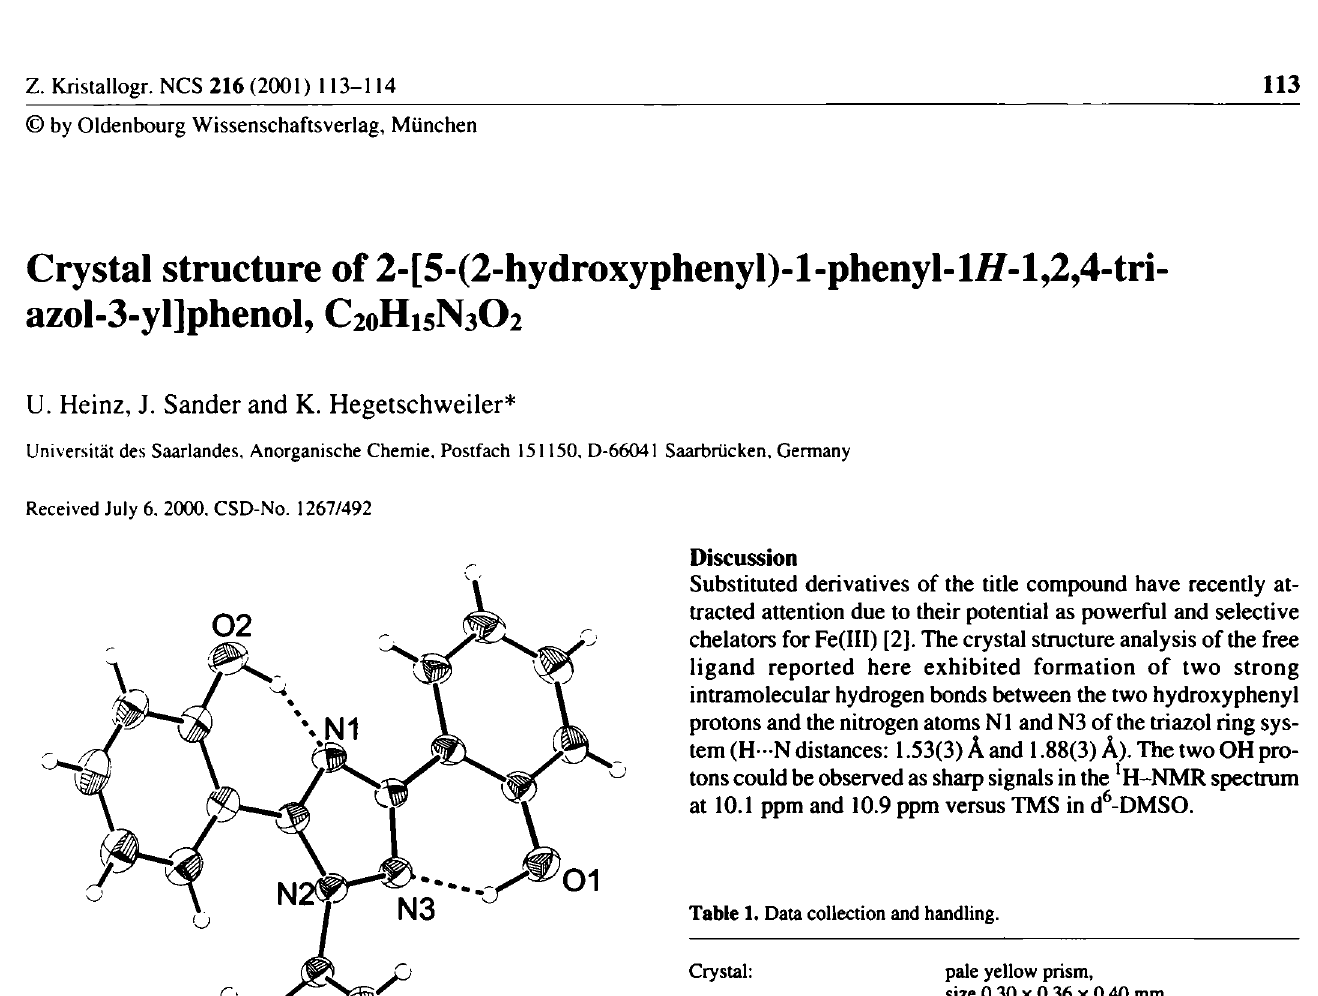
Table 2. Atomic coordinates and displacement parameters (in Ä 2